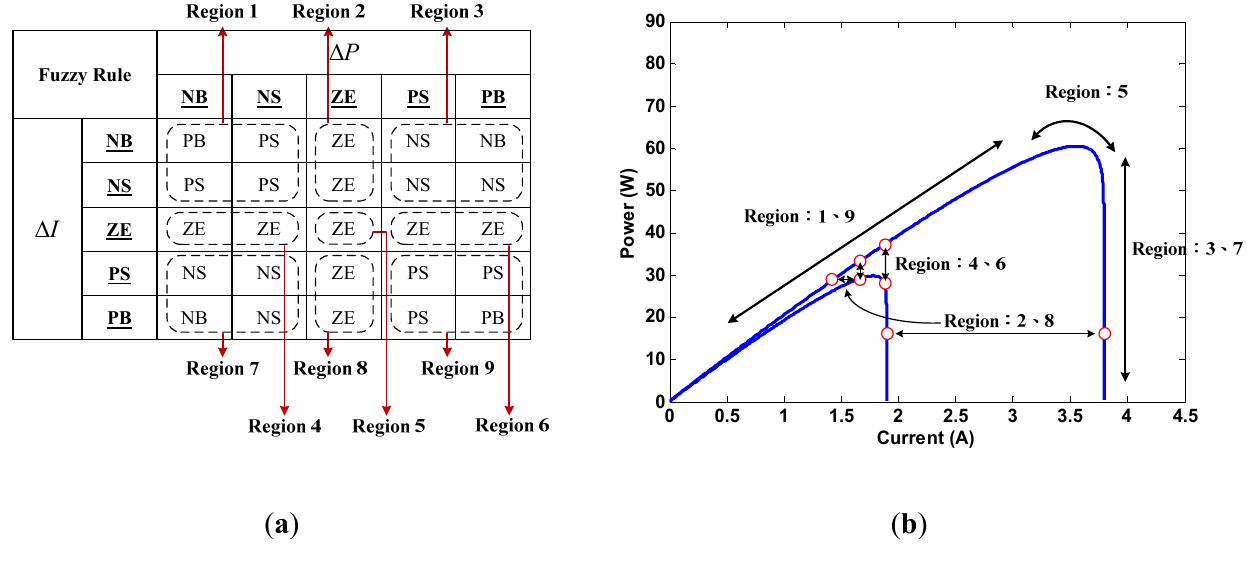
Figure 17. Fuzzy rules for Algorithm